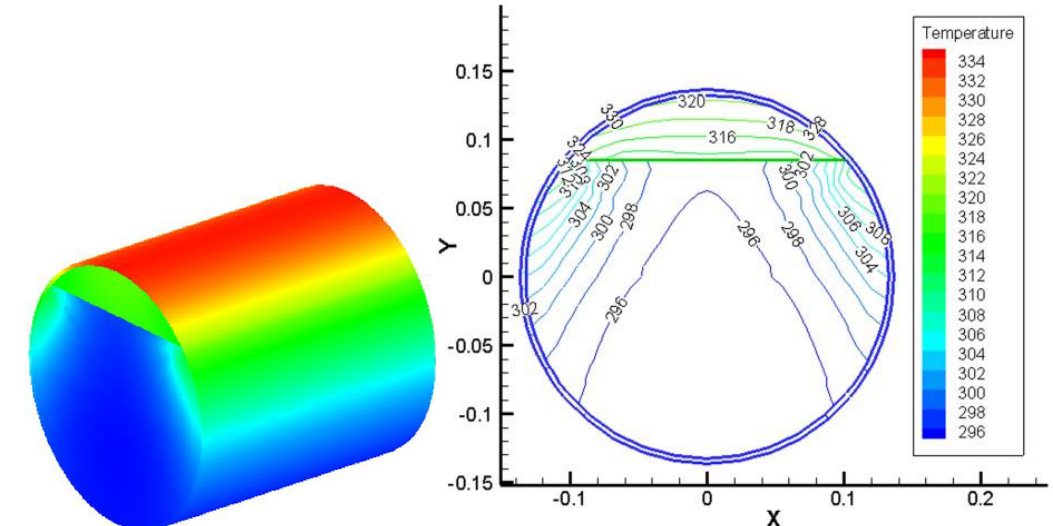
Figure 4. Temperature cloudy map and isopleth in Model 3 (unit: K).